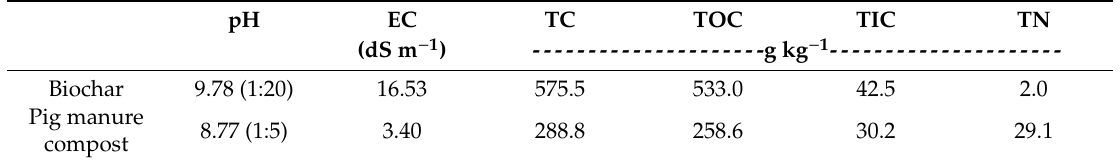
Table 1. Physicochemical properties of biochar and pig compost used 1) .